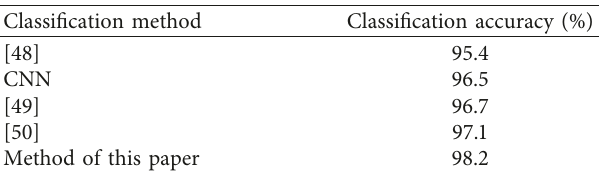
Table 2: Comparison table of breast tumor image classification